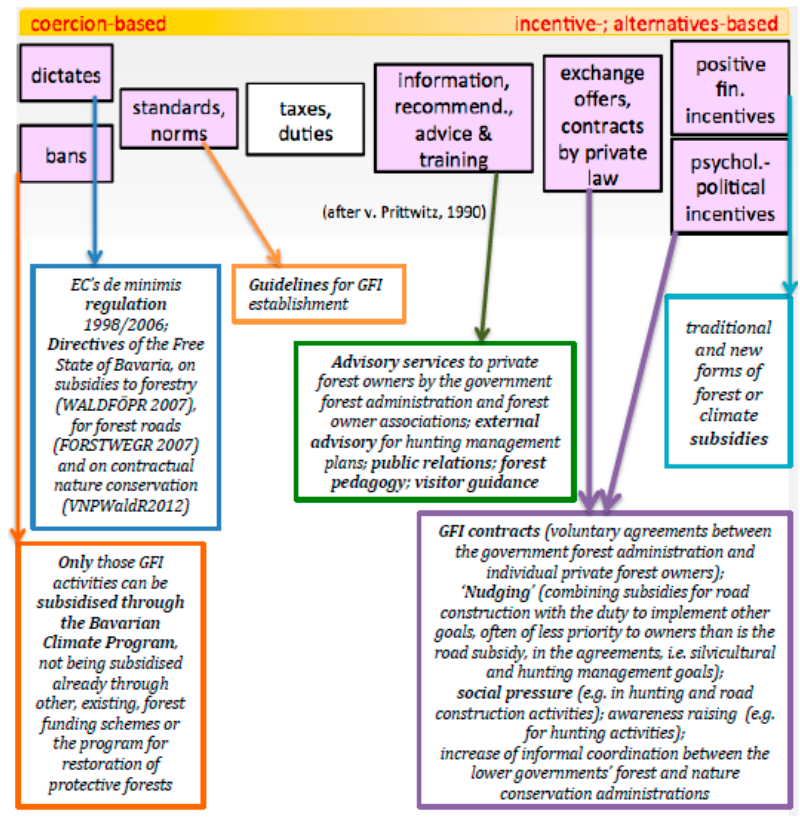
Figure 3. Overview and empirical examples on the instrument mix applied in GFIs.